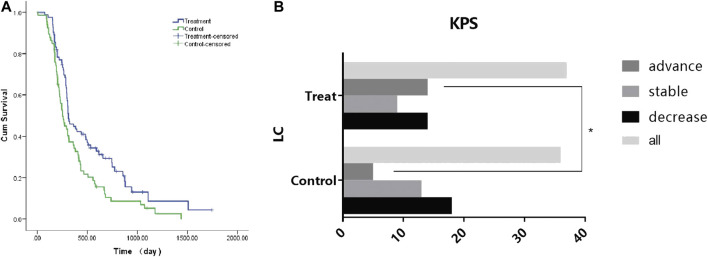
Survival and KPS analysis in CRC treated with BSJPJDD (n = 3) snd without BSJPJDD (n = 66). (A) Survival analysis, (B) KPS *p < 0.05, BSJPJDD group vs control group.